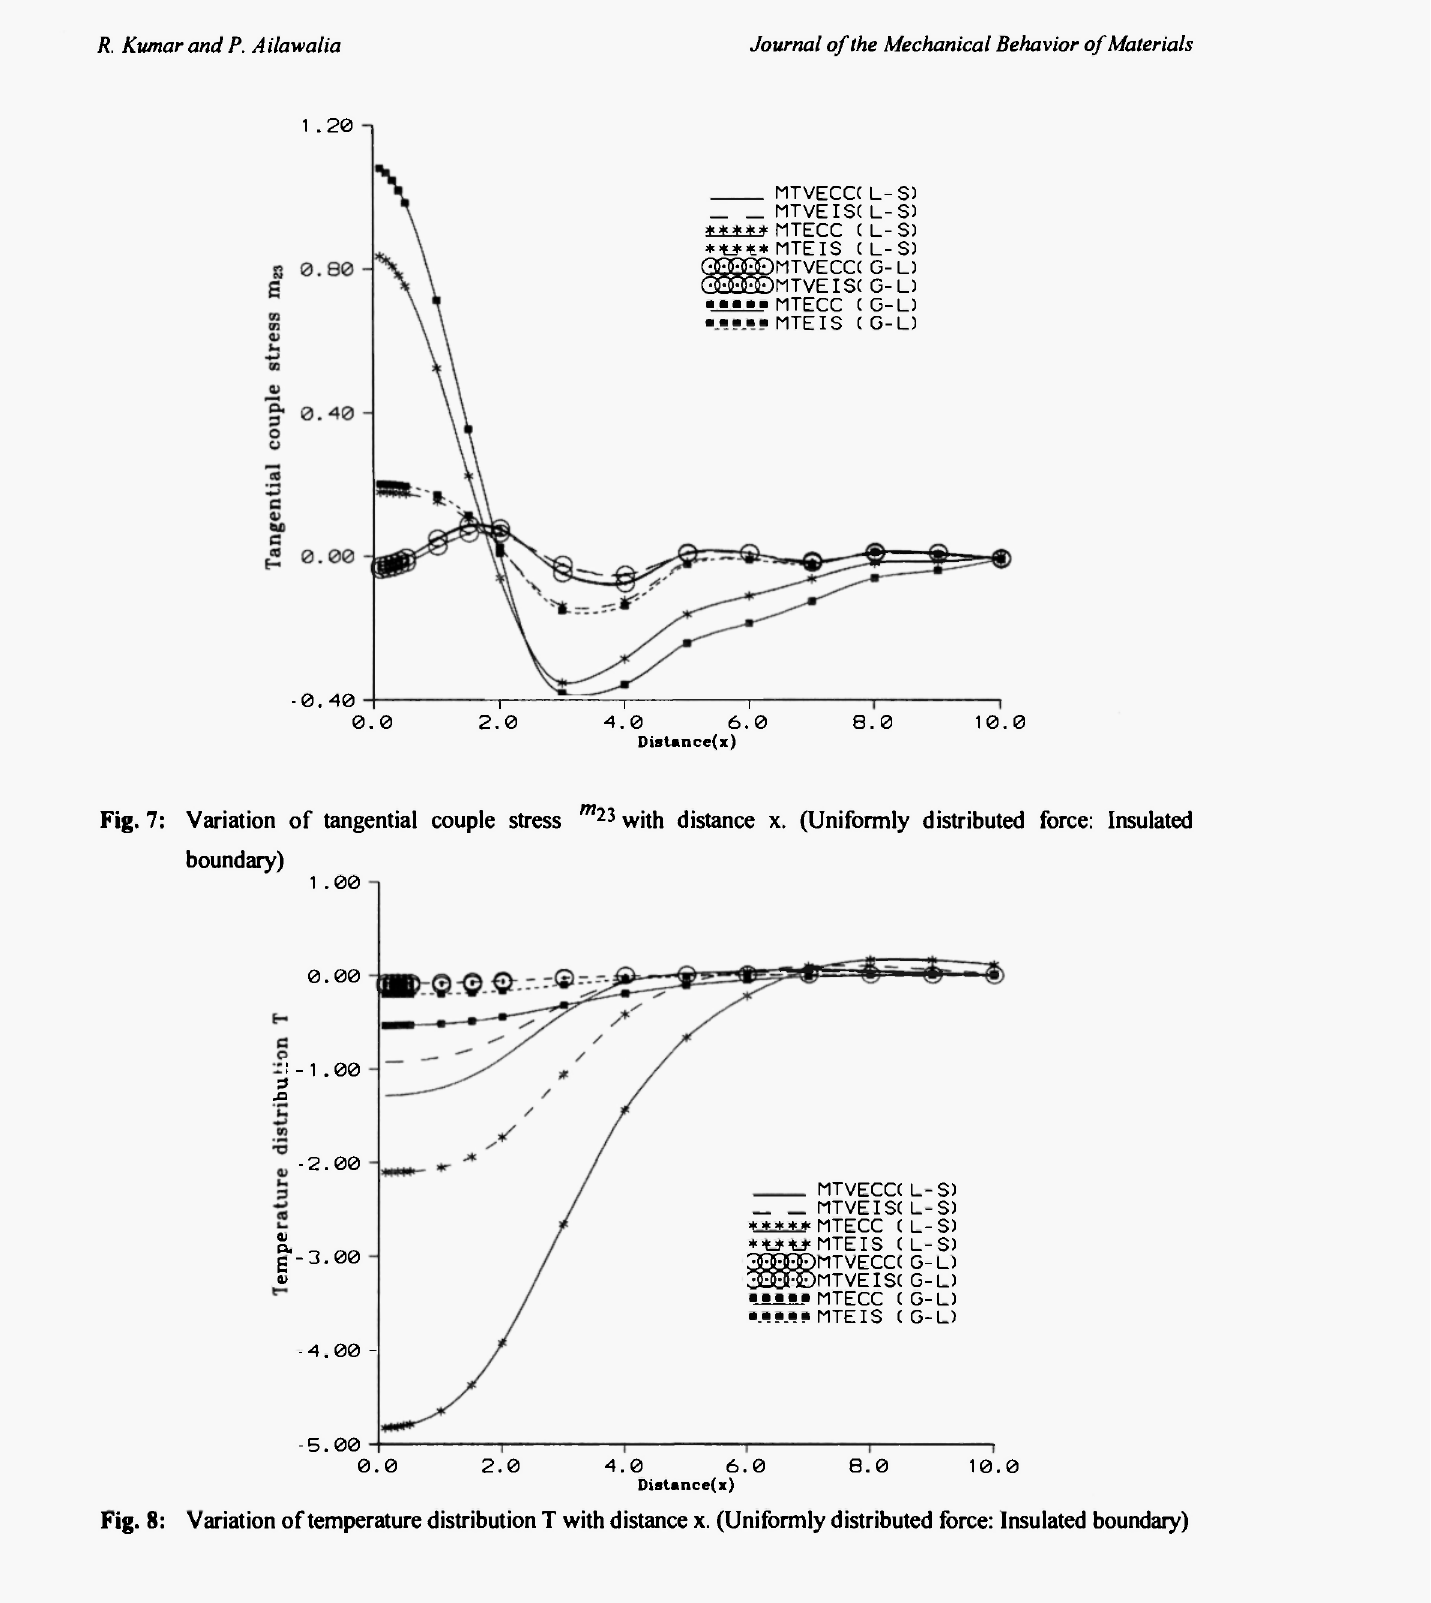
Fig. 8: Variation of temperature distribution Τ with distance χ. (Uniformly distributed force: Insulated